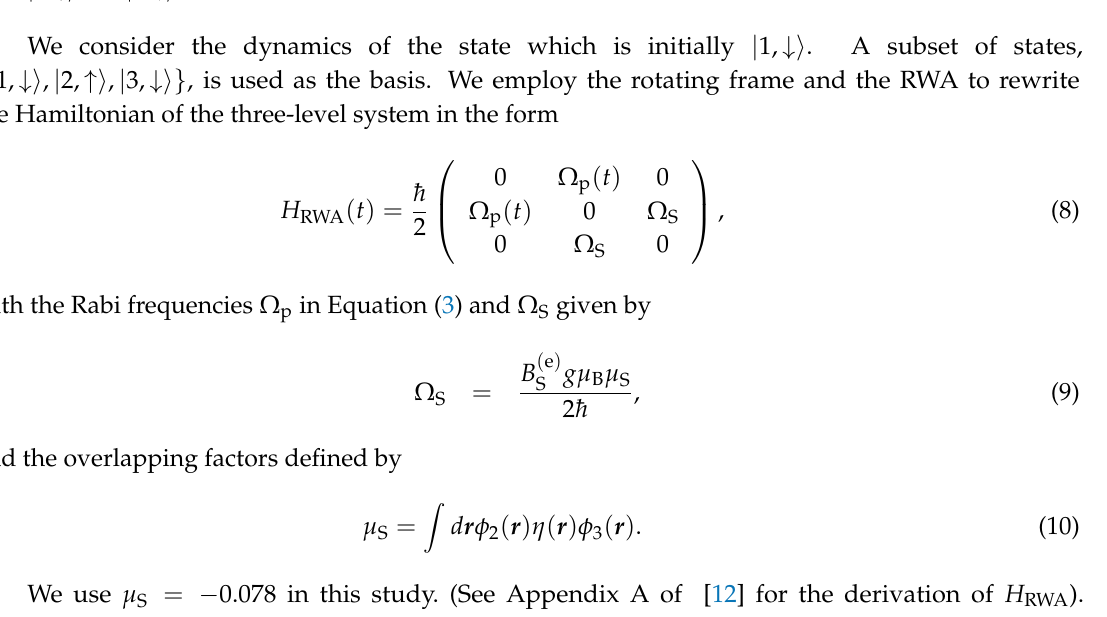
Figure 4. ( a ) Schematic description of the spin-selective single electron transfer. The black curves show the potential profiles of the quantum dot(s). The blue color represents the squared amplitude of the wave function of an electron whose initial spin was down. ( b ) Energy diagram of the system in Step I. The AC magnetic field B p (pump field) couples | 1, ↓(cid:105) and | 2, ↑(cid:105) , while B S (Stokes field) couples | 2, ↑(cid:105) and | 3, ↓(cid:105)